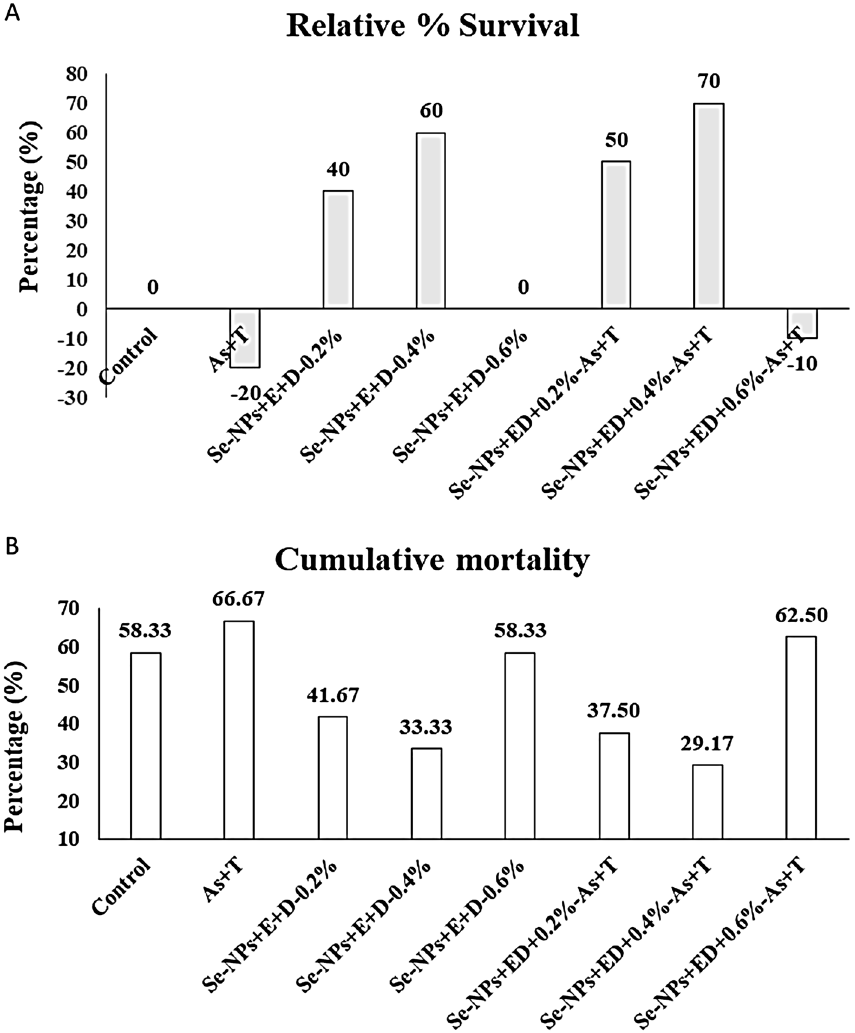
Figure 5. ( A , B ) Mitigation of tertiary stress response (relative survival (%) and cumulative mortality) through dietary supplementation of selenium nanoparticles, eicosapentanoic acid and dicosahexanoic acid fed to P. hypophthalmus reared in control or under arsenic and high temperature (As + T) for 105 days. Data expressed as Mean ± SE (n =